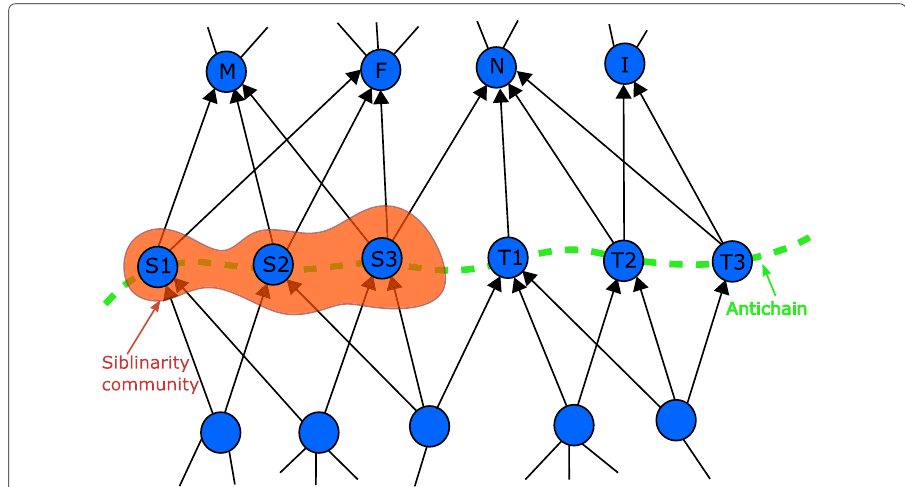
Fig. 1 An antichain is a subset of nodes in the graph, such that none of the nodes are pairwise connected with edges or paths. In this illustration, an antichain is composed of nodes { S 1 , S 2 , S 3 , T 1 , T 2 , T 3 } (the green dotted line is drawn as a guide of eye). Although in the same antichain, not all nodes share many neighbours. Nodes { S 1 , S 2 , S 3 } share many successors (they are all connected to nodes M , F ), so we join them in a Siblinarity